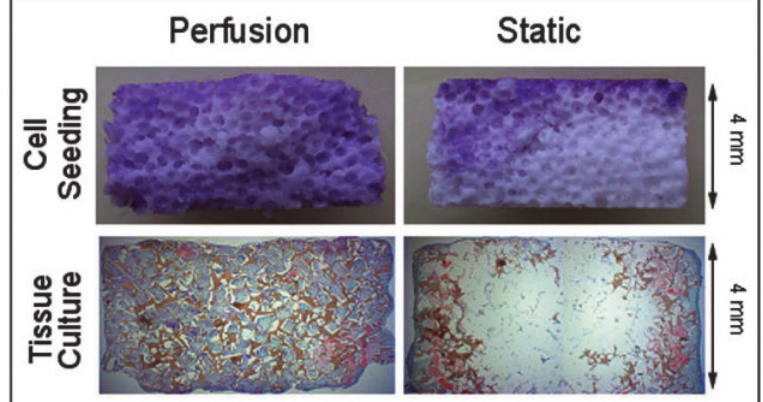
Cell distribution and matrix synthesis under perfusion and static conditions. Seeding of cells in a perfusion-based bioreactor system results in a uniform distribution of cells (here stained purple) throughout the scaffold as compared to conventional static seeding conditions [52]. Subsequent culture under perfusion additionally supports a more homogeneous tissue formation and avoids the formation of a necrotic centre typical of statically cultured cartilage grafts